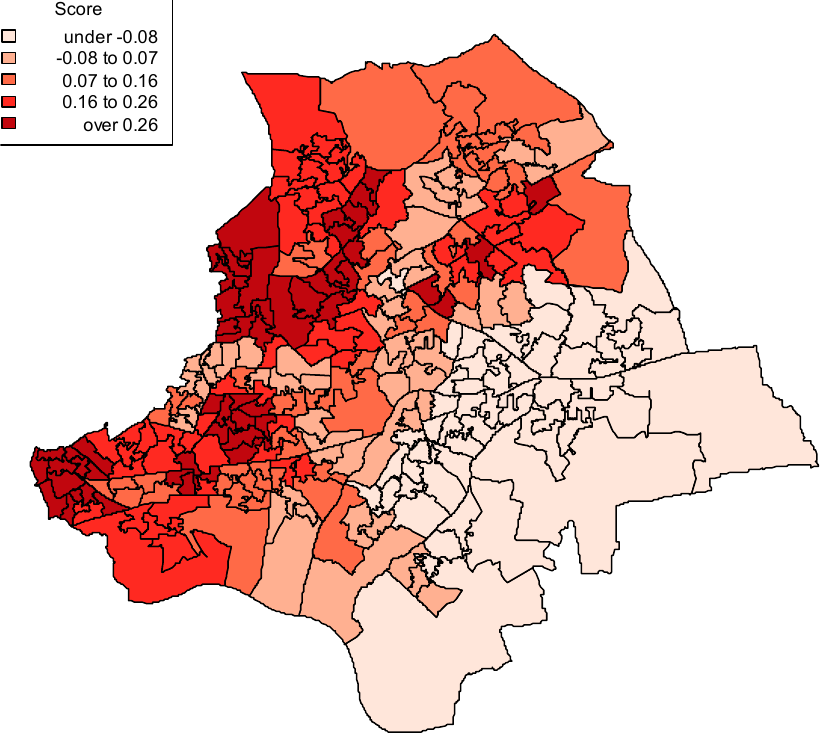
Figure 4. LSOA averages on posterior mean access scores, model 3.